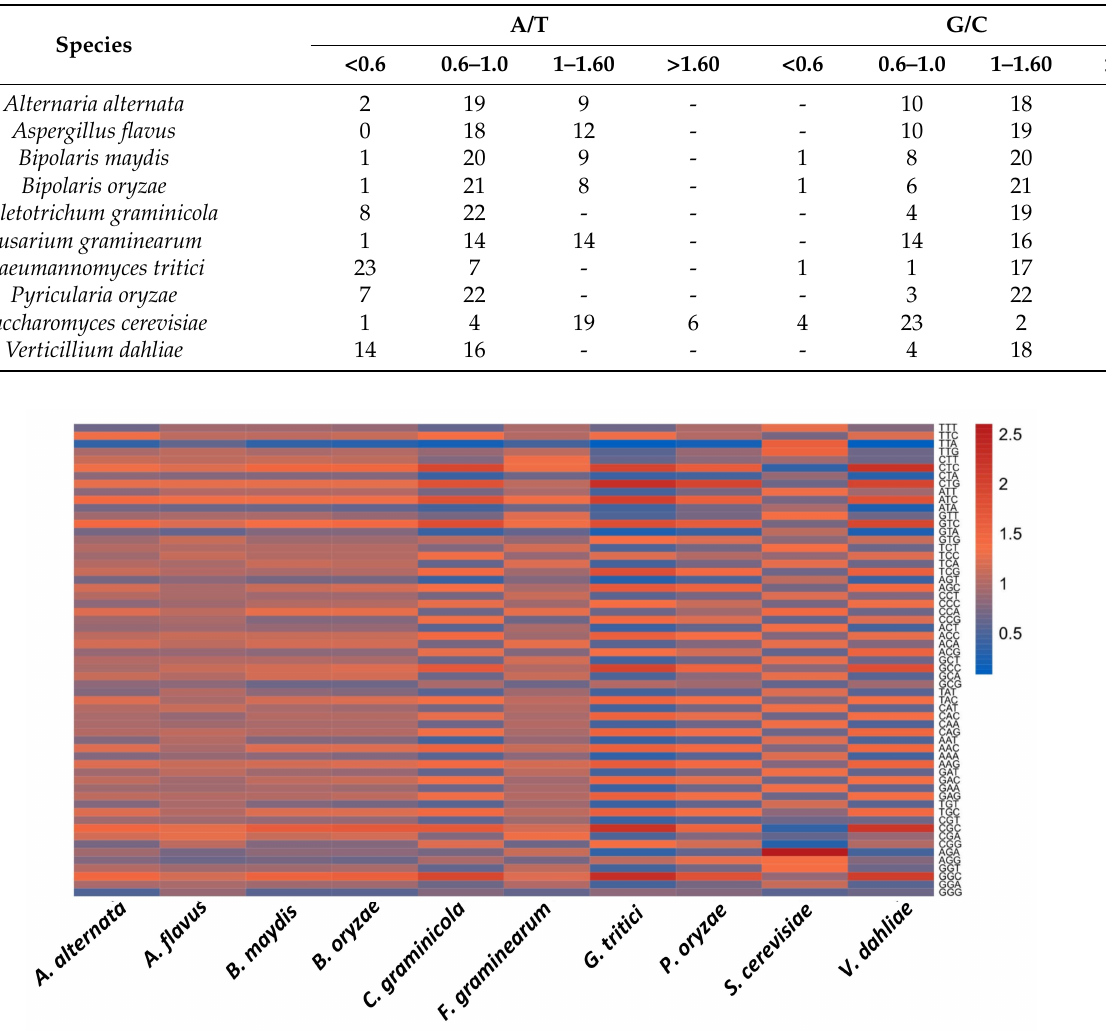
Figure 2. The heat map showing the relative synonymous codon usage (RSCU) in zinc binuclear clusters in various Ascomycetes plant pathogenic fungal species and model yeast